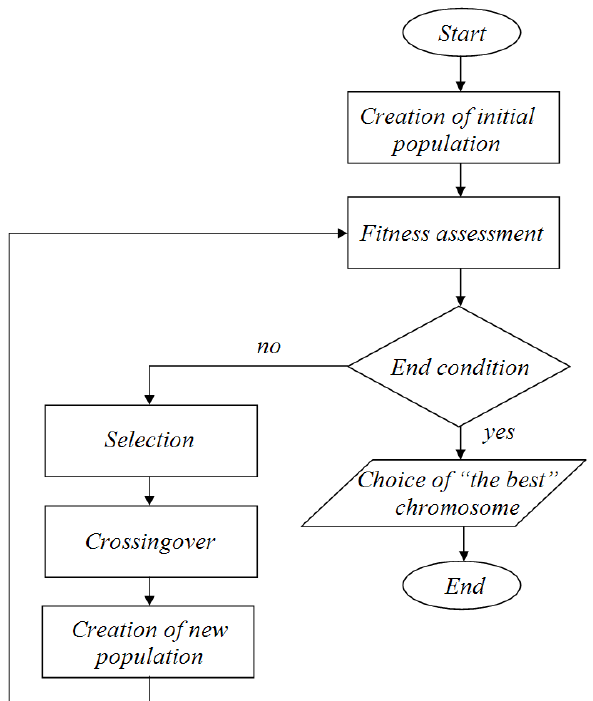
Figure 6. The GA algorithm flowchart (Whitley, 1994)